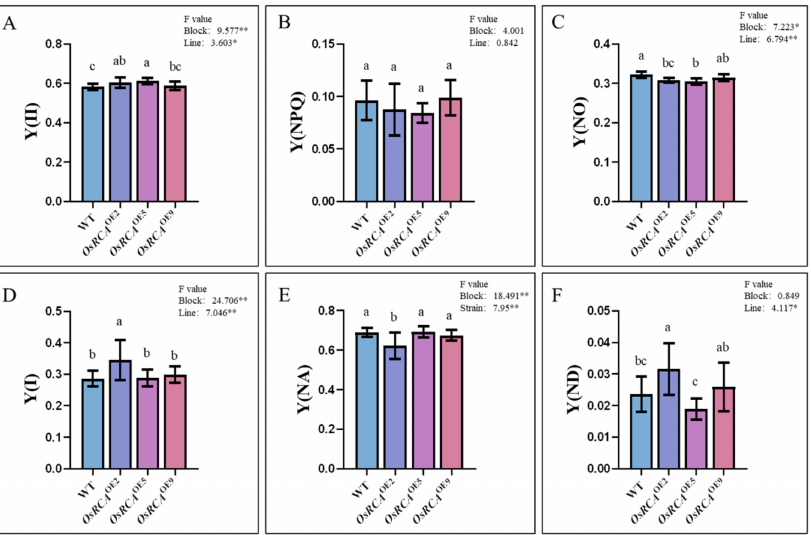
Figure 3. PSII and PSI energy conversion–related parameters of WT and OsRCA OE lines. ( A ) Y(II), PSII photochemical energy conversion yield. ( B ) Y(NPQ), the quantum yield of regulatory energy dissipation at PSII. ( C ) Y(NO), quantum production of non–regulatory energy dissipation at PSII. ( D ) Y(I), PSI photochemical energy conversion yield. ( E ) Y(NA), the non–photochemical quantum yield of the PSI acceptor side. ( F ) Y(ND), the non–photochemical quantum yield of the PSI donor side. Different letters above the bars indicate significant differences between different lines at p < 0.05. * p < 0.05, ** p <